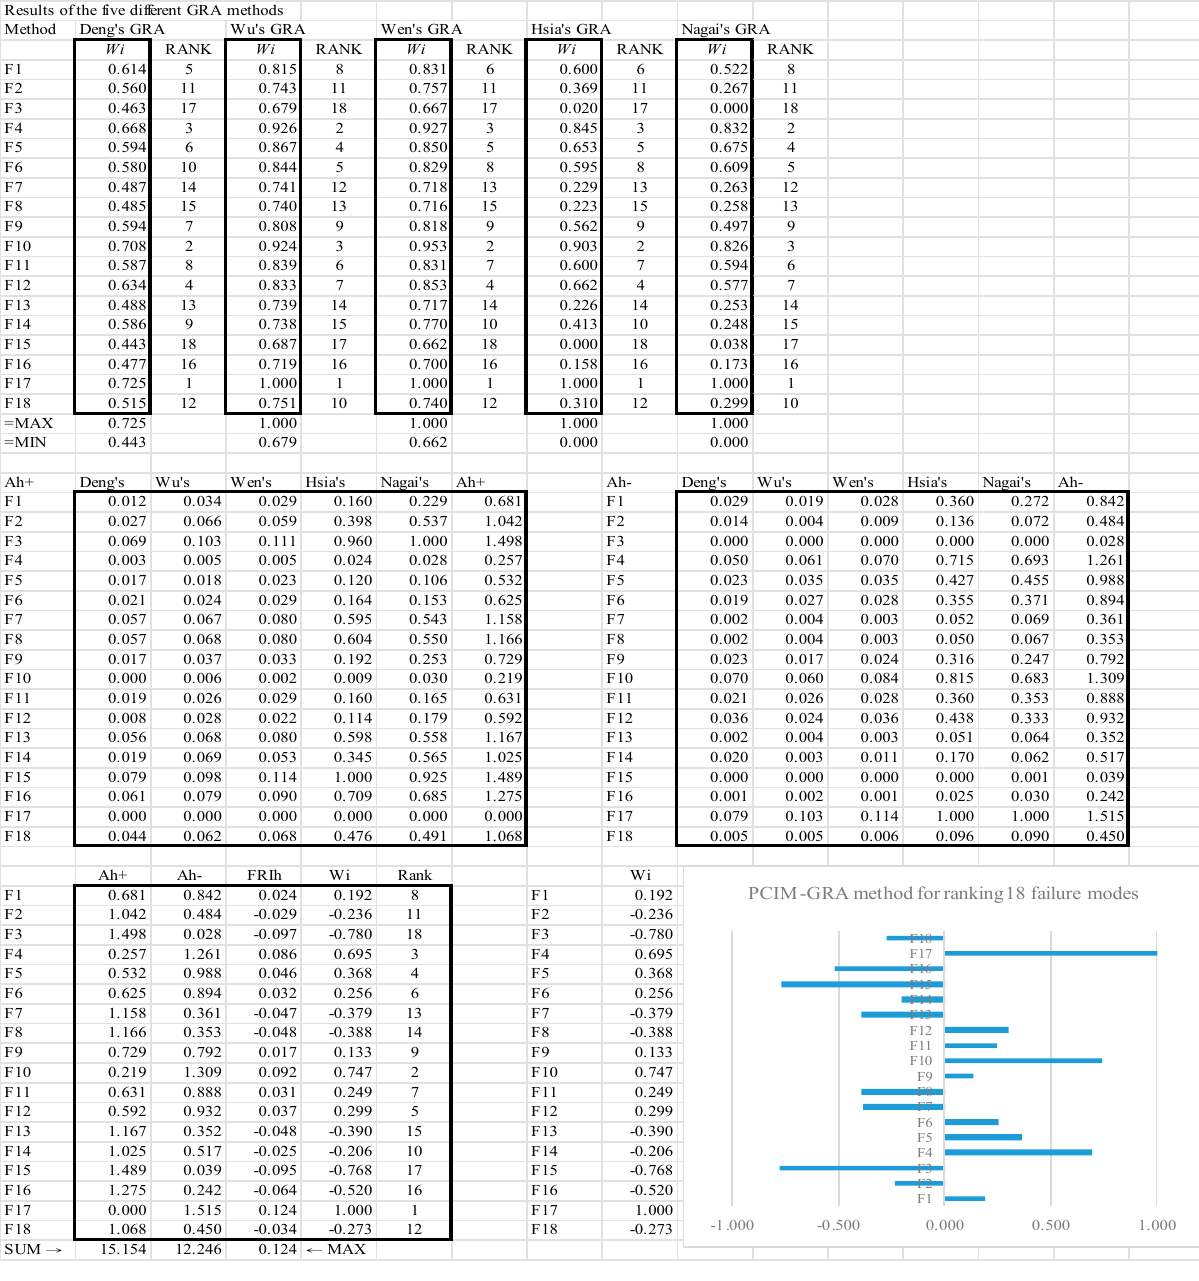
Figure A4. The PCIM − GRA calculation steps for ranking 18 failure modes by